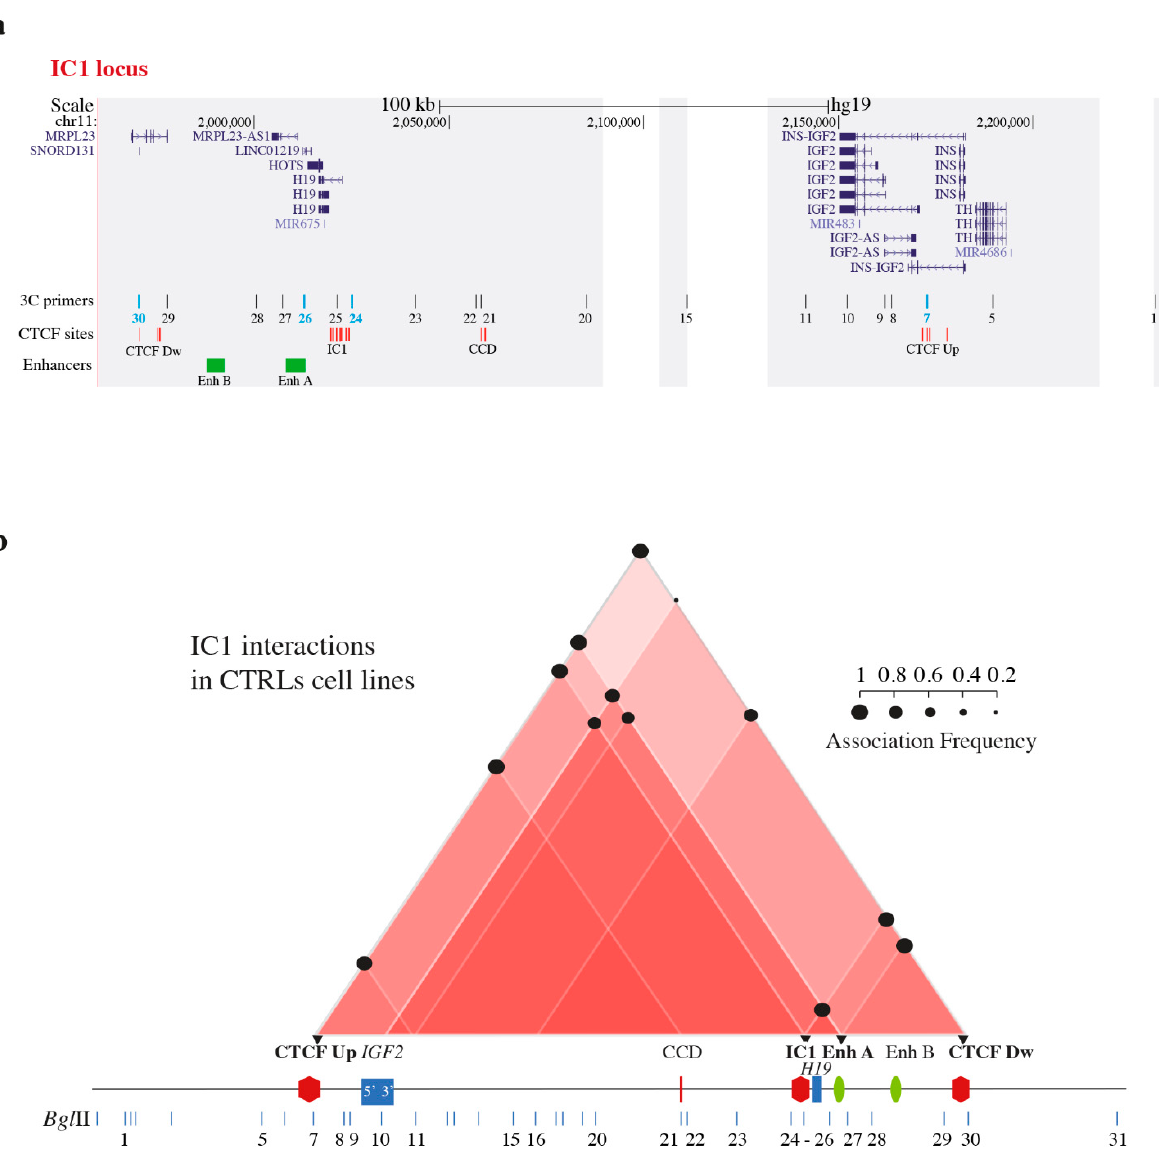
Figure 1. 3C and interactome analyses in control cell lines. ( a ) Scheme of the IC1 locus under analysis (UCSC Genome Browser map position 1,960,000 to 2,235,000). Areas covered by 3C analysis are highlighted in grey. The locations of genes are indicated in the upper part. Vertical black lines, corresponding to BglII restriction sites, indicate the primers used for 3C analysis. Anchor primers are highlighted in turquoise. Red and green lines indicate clusters of CTCF-binding sites in reverse or forward orientation, respectively. Green bars (EnhA and EnhB) correspond to enhancer regions. CTCF-binding sites: CTCF Up, CCD, IC1, and CTCF Dw. ( b ) Schematic representation of the IC1 domain interactome in control cell lines. The data for each cell line were derived from two independent 3C experiments. Interactions between different elements of the IC1 region are shown by red triangles; increasing color intensity corresponds to an increase in the number of interactions of the subregion. Mean association frequencies of CTRL1 and CTRL2 are indicated with black circles. Black triangles indicate the anchors used for 3C analysis. A linear representation of the domain is shown below. In accordance with the transcription of genes in the region, panel b was drawn in reverse orientation with respect to the map in panel a. Adapted from [31] following the Creative Commons Attribution 4.0 International License.